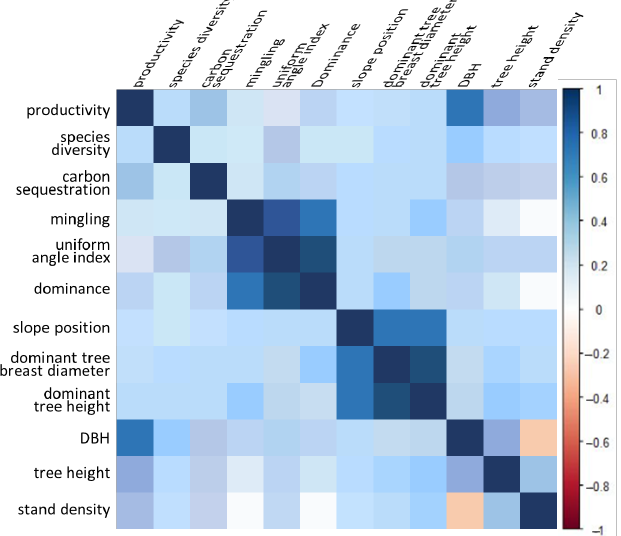
Figure 1. Correlation heat map between structure variables and function variables. The dominance, mingling and uniform angle index are very significantly